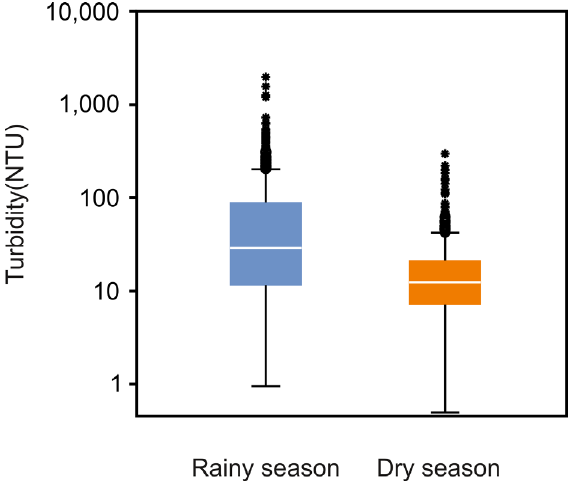
Figure 2. Box diagram for turbidity values in the rainy (October to March) and dry (April to September) periods between 2012 and 2018. The turbidity values are presented on a logarithmic scale. The central line inside the box represents the median, and the upper and lower limits of the box represent the first and third quartiles values, respectively. The distinctiveness of turbidity during dry and wet seasons is controlled by the variation of the river